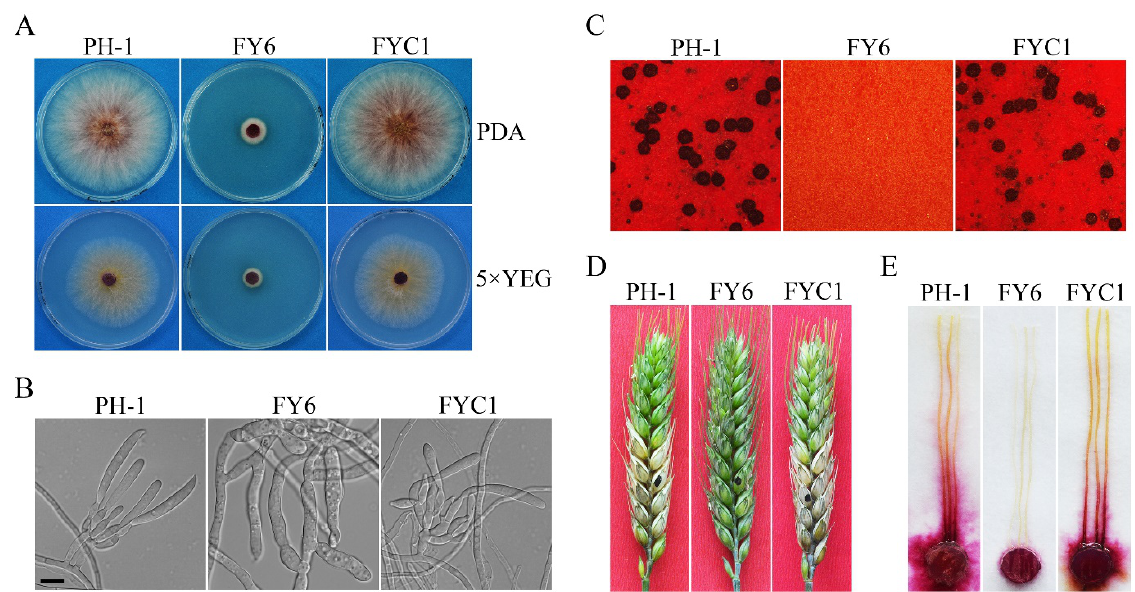
a Average radial growth per day on PDA plates. b Conidiation in 5-day-old CMC cultures. c Diseased spikelets per wheat head at 14 dpi. * Mean and standard deviation were calculated with data from three independent measurements. Different letters (A–C) indicate significant differences by Dun- can’s multiple rage test ( p = 0.05).